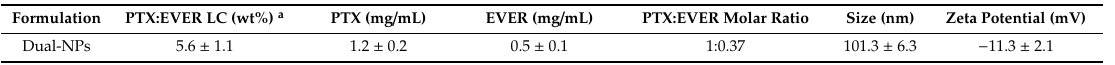
Scheme 1. Graphical schematic depicting the composition of dual-targeted paclitaxel (PTX) + everolimus (EVER)-loaded nanoparticles (Dual-NPs). Adapted with permission from “Loujin Houdaihed, James C. Evans, Christine Allen. Codelivery of Paclitaxel and Everolimus at the Optimal Synergistic Ratio: A Promising Solution for the Treatment of Breast Cancer. Molecular Pharmaceutics . Table 1. Drug loading, size, and surface charge of dual-targeted paclitaxel (PTX) + everolimus (EVER)-loaded nanoparticles (Dual-NPs).